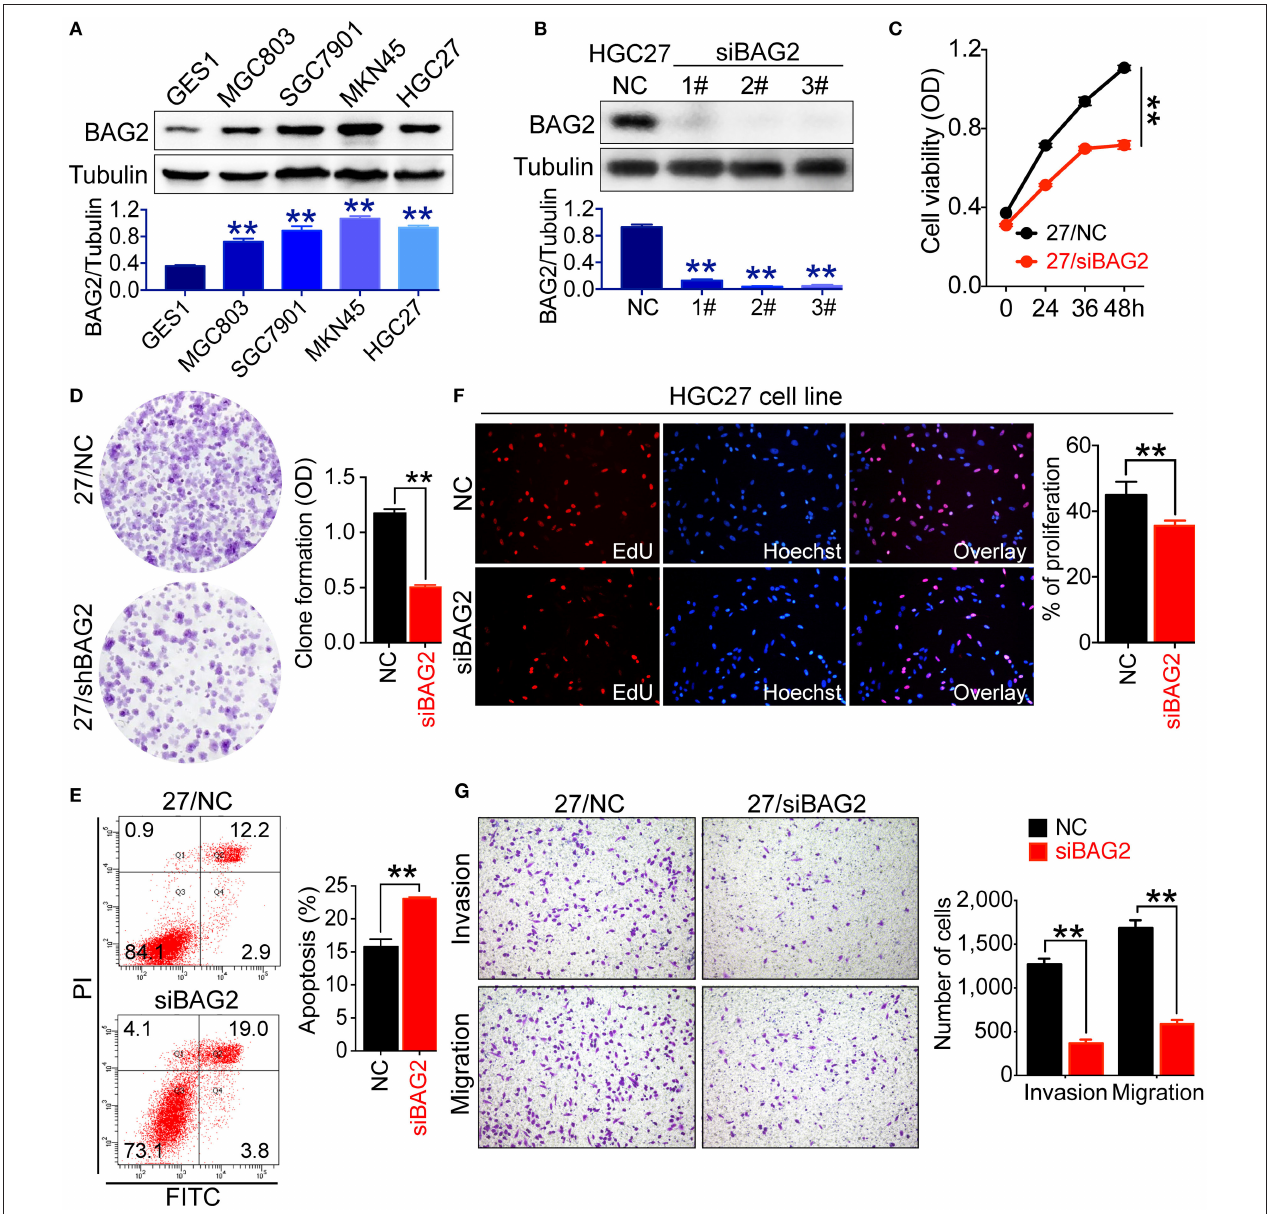
FIGURE 2 | Biological function of BAG2 in gastric cancer cells. (A) Expression of BAG2 in GES1 and several gastric cancer cell lines (MGC803, SGC7901, MKN45, HGC27) showed that BAG2 expressed lowest in GES1 cell line; (B) Interference efficiency of BAG2 -specific siRNAs; (C–G) Effect of BAG2 knockdown on cell viability (C) , colony formation and cell apoptosis (D) , cell proliferation (F) , invasion and migration (G) of gastric cancer cells. ** P < 0.01. 27/NC stands for HGC27/NC and 27/ siBAG2 stands for HGC27/ siBAG2